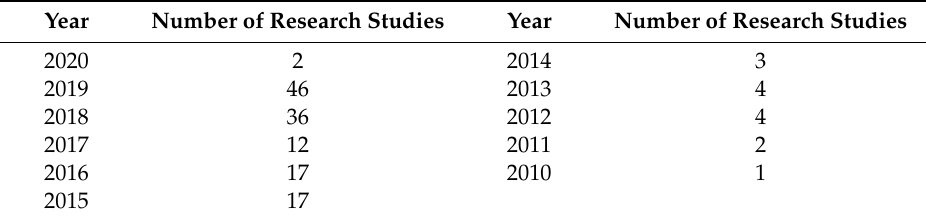
Table 3. Number of studies per year included in the